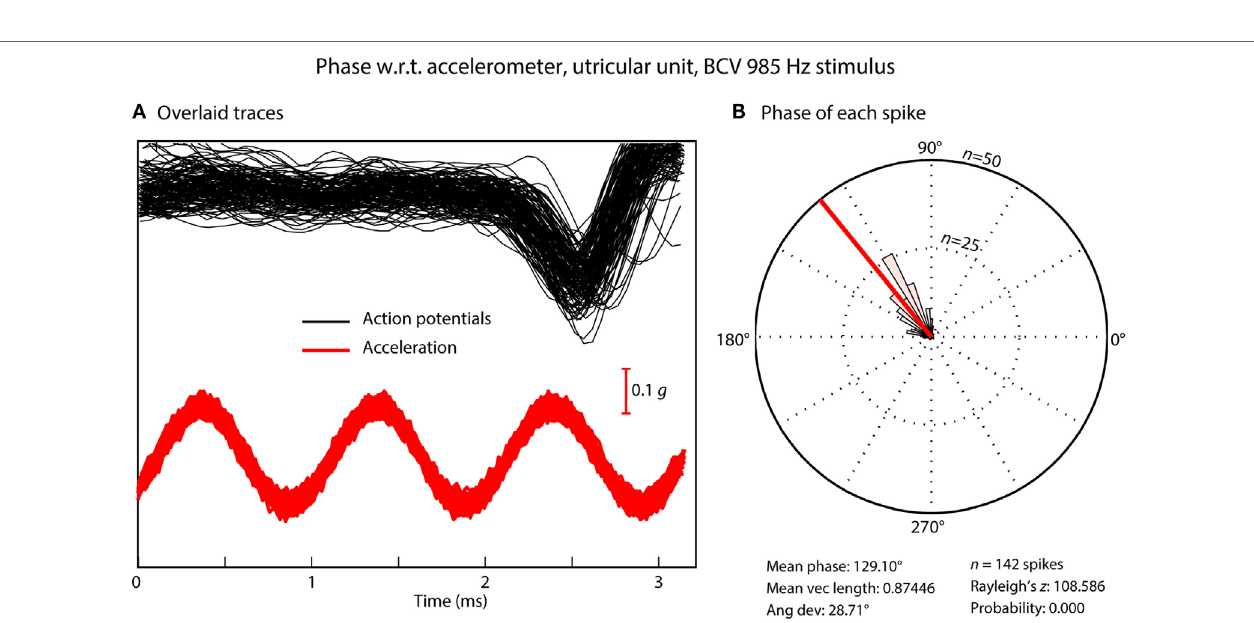
FigURe 4 | (A) Time series of action potentials in response to a bone-conducted vibration stimulus (shown by the red acceleration trace). Traces which contain a spike of neural firing are aligned using the timing of the stimulus pulse. (B) Circular histogram (rose plot) of the phase of each spike; the small and large concentric circles represent n = 25 and n = 50 spikes, respectively. The Rayleigh test of circular uniformity was performed on the 142 spikes, and was significant ( p < 0.001), showing that the time when an afferent is activated is phase locked to the stimulus. Here, the neuron misses many cycles (A) , as can be seen from the value of the action potentials which contain no spikes in the cycles preceding each instance of firing, but the time when the neuron fires is locked to a narrow band of phase angles of the stimulus (B) . Clearly each individual cycle of the stimulus is acting to activate the receptor/afferent.